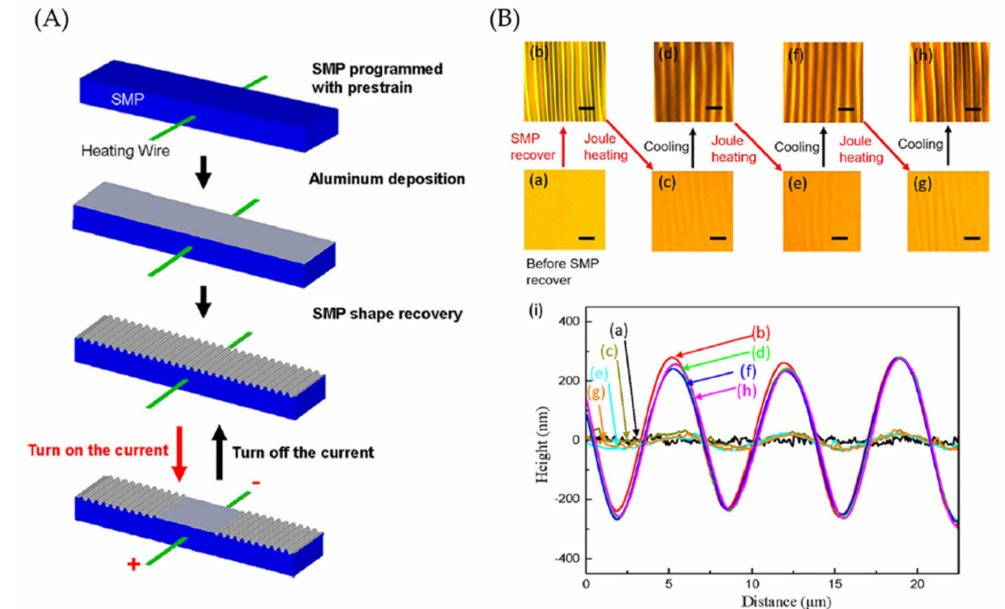
Figure 14. ( A ) Schematic illustration of the fabrication process to fabricate wrinkled patterns on SMP and locally flatten the surface using joule heating and ( B ) optical microscopy images of the surface in the reversible and repeatable tuning process (a)–(h) and the corresponding profiles (i) for Joule heating with a current of I = 0.45 A and heating for 3 min and cooling for 5 min. Reproduced with permission from reference [65]. Copyright 2019, AIP Publishing